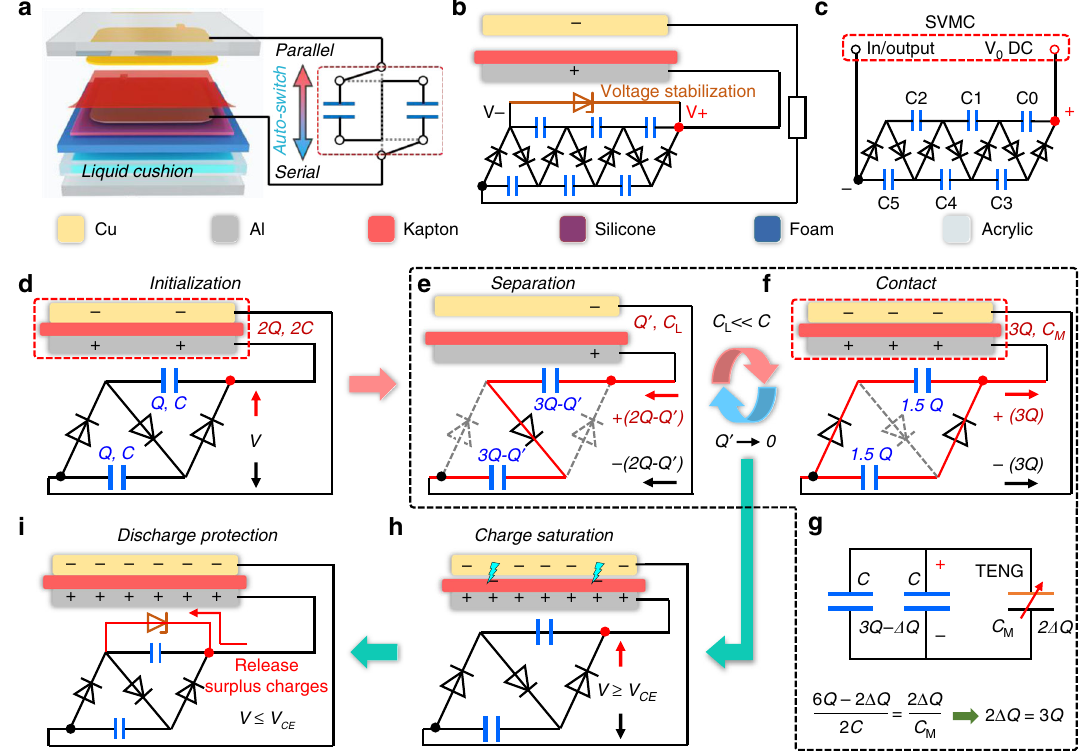
Fig. 3 Principle of the self-charge excitation triboelectric nanogenerator. a The fundamental scheme of self-charge excitation triboelectric nanogenerator (SCE-TENG), the auto-switch can change capacitors from parallel to serial connection during the operation cycle. b The systematical electric circuit scheme of SCE-TENG. c The input/output node and scheme of self-voltage-multiplying circuit (SVMC). d The charge distribution of SCE-TENG in initial state (simpli fi ed from one SVMC unit). e – g Charge excitation process during periodically contact-separation cycle. h , i Air breakdown caused by high charge density and discharge protection circuit,